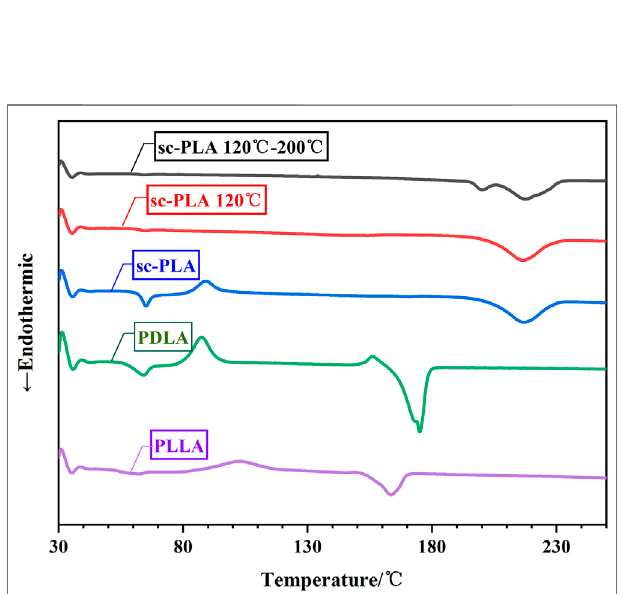
FIGURE 1 | SEM of electrospun fi bers: (A) PDLA, (B) PLLA, (C) sc-PLA, (D) sc-PLA 120 ° C, (E) sc-PLA 120 ° C – 200 ° C, and (F) high magni fi cation sc-PLA 120 ° C – 200 ° C.